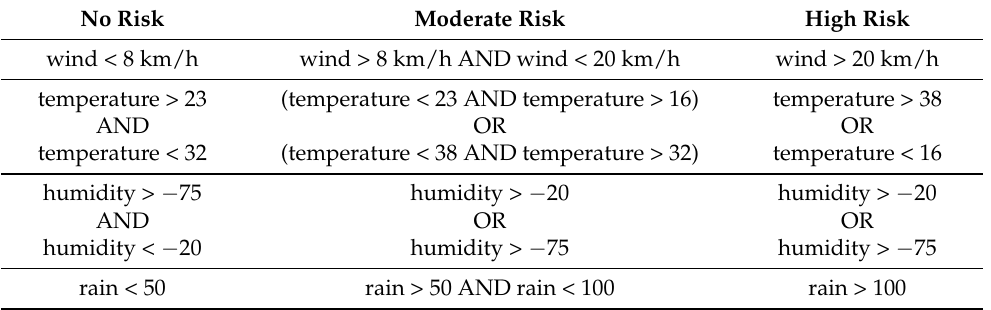
Table 1. Definition of risk levels for alarm detection.